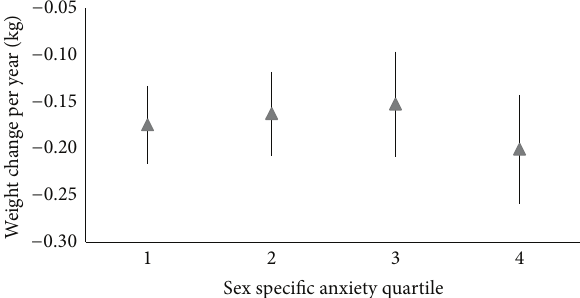
Figure 3: Graph of the mean and related confidence intervals of the change in weight per year (kg) by sex-specific anxiety quartiles.